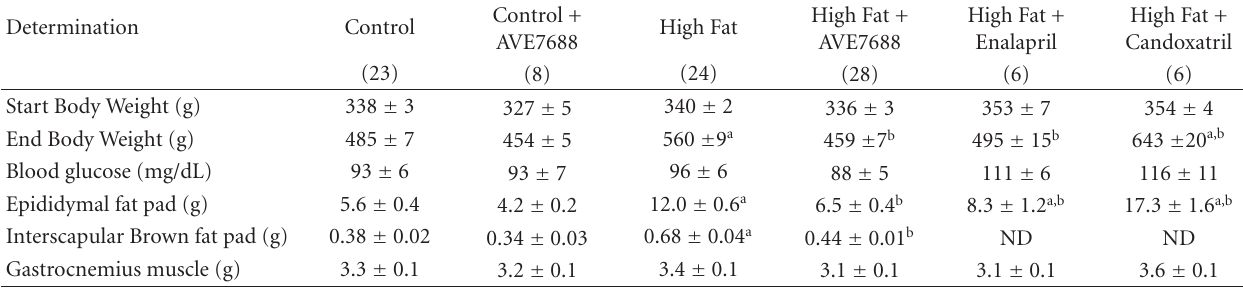
Table 1: E ff ect of high-fat diet ± AVE7688, Enalapril or Candoxatril on blood glucose and change in body weight, fat pad and muscle mass. Determination